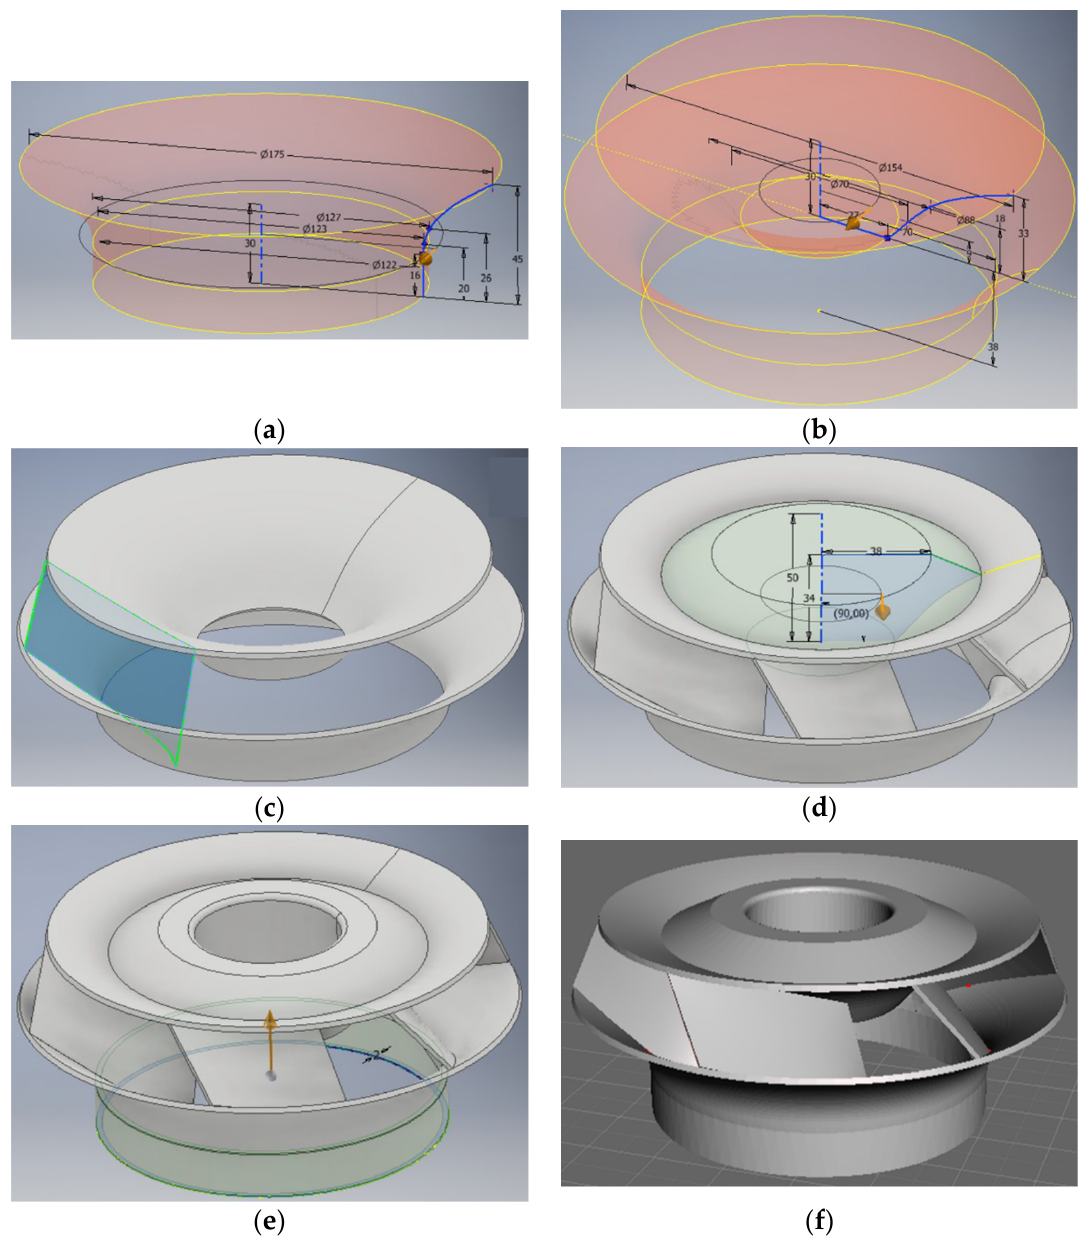
Figure 4. Modelling process of the impeller: ( a ) surface of revolution from the 2D sketch of the lower flared part; ( b ) surface revolution of the upper flared part; ( c ) thickening of the walls and definition of the geometry of a blade; ( d ) reproduction of the blades around the profile of the impeller; ( e ) creation of the central hole and of the wear ring at the base of the impeller; and ( f ) resulting 3D model. All the dimensions are expressed in mm.